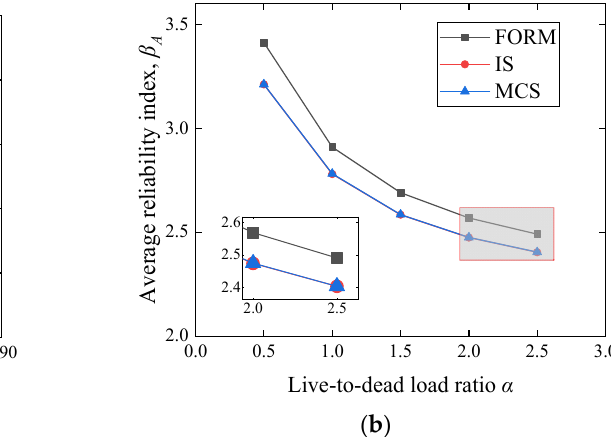
Figure 9. Reliability index comparison of different methods. ( a ) Effect of ϕ A on β A with different methods, ( b ) effect of α on β A with different methods.